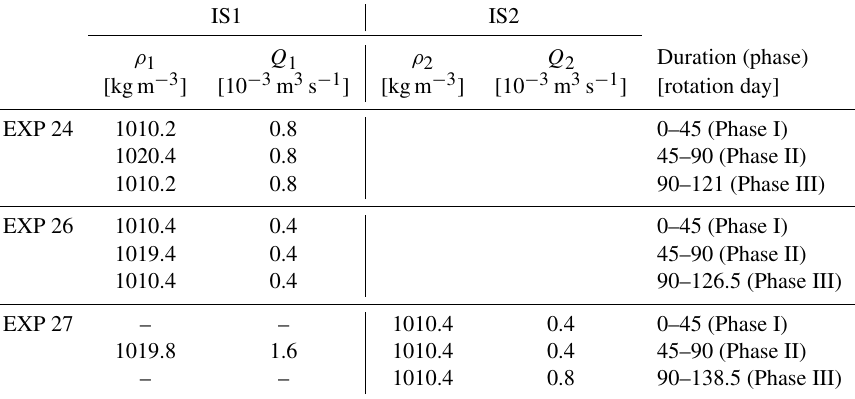
Table 2. Configuration of injection sources IS1/IS2: ρ 1 /ρ 2 and Q 1 /Q 2 are the densities and discharge rates, respectively, of injected